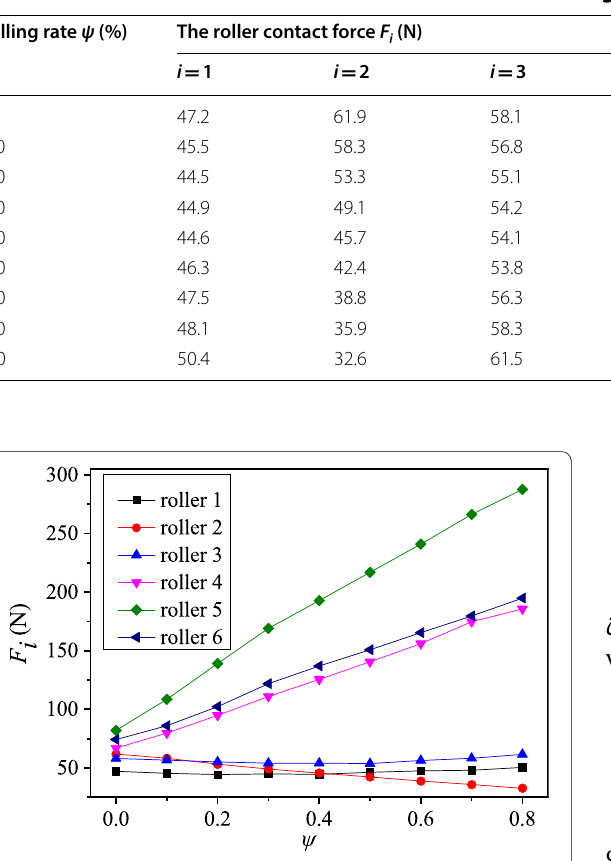
Figure 3 Variation curve of the normal force with filling rate